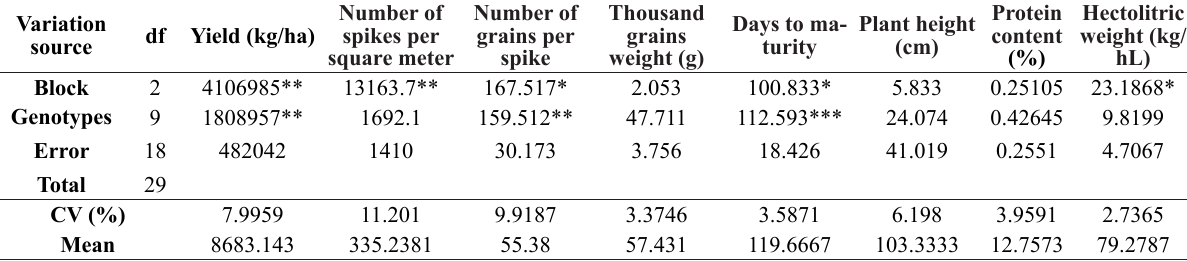
Table 3. Mean squares of the analysis of variance of grain yield, number of spikes per square meter, number of grains per spikes, thousand grains weight (g), days to maturity, plant height (cm), protein of grains (%) and hectolitric weight (kg/hL) of the control experiment of the assessment of tolerant wheat genotypes (Triticum aestivum L.) to drought under conditions of La Molina LM 2019B